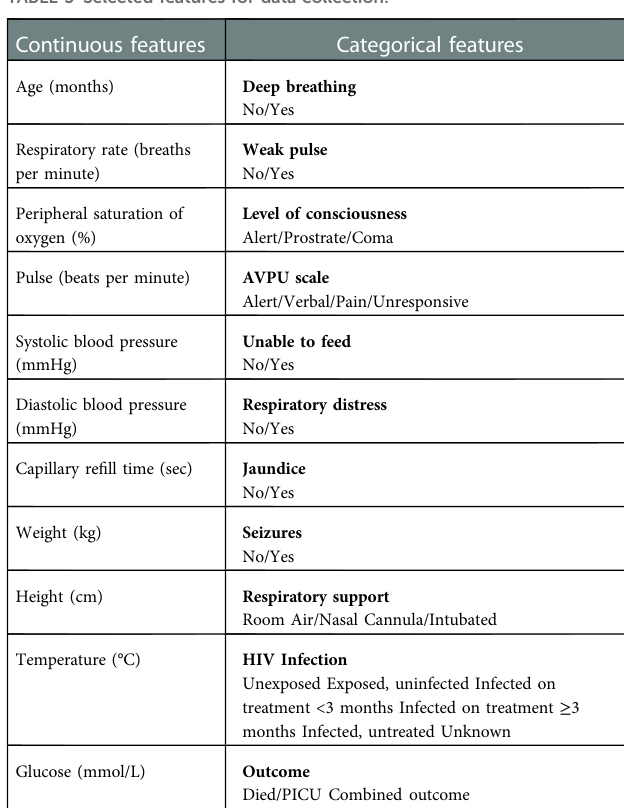
TABLE 3 Selected features for data